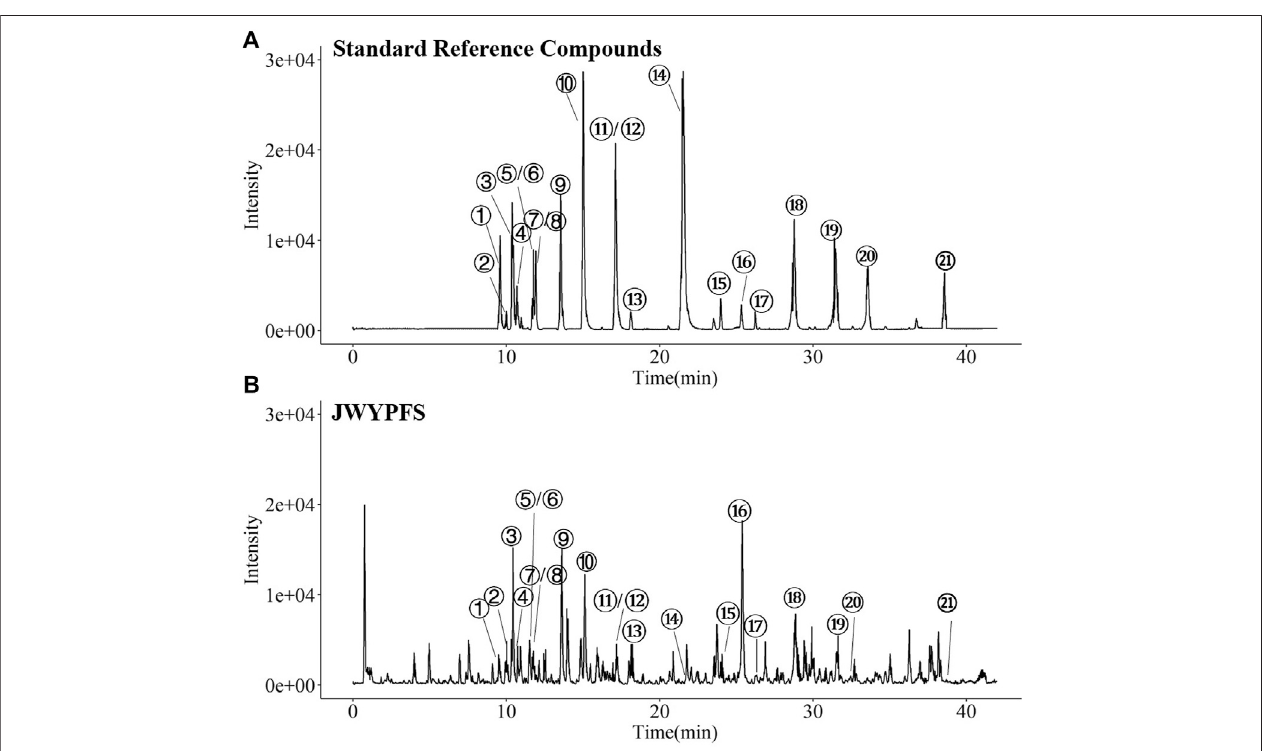
FIGURE 1 | HPLC-Q-TOF-MS. Chromatographical pro fi le of standard reference (A) and JWYPFS (B) . The main components represented by number 1 – 21 are shown in Table 3 . ① Psoralenoside, ② Isopsoralenoside, ③ Prim-O-glucosylcimifugin, ④ Orientin, ⑤ Liquiritin, ⑥ Liquiritin apioside, ⑦ Vitexin, ⑧ Ellagic Acid, ⑨ 4 ′ -O-